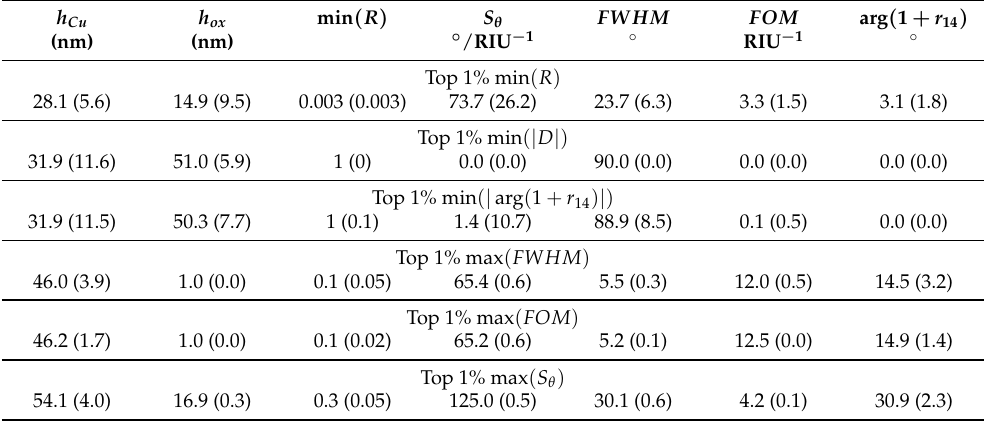
Table 3. Mean optimal thicknesses for the top 1% performance parameters of the SPR set up in the dry case according to the minimum of reflectance, sensitivity, full width at half maximum, figure of merit and argument of the total field on the glass-copper interface. In brackets, standard deviation of the top 1%.